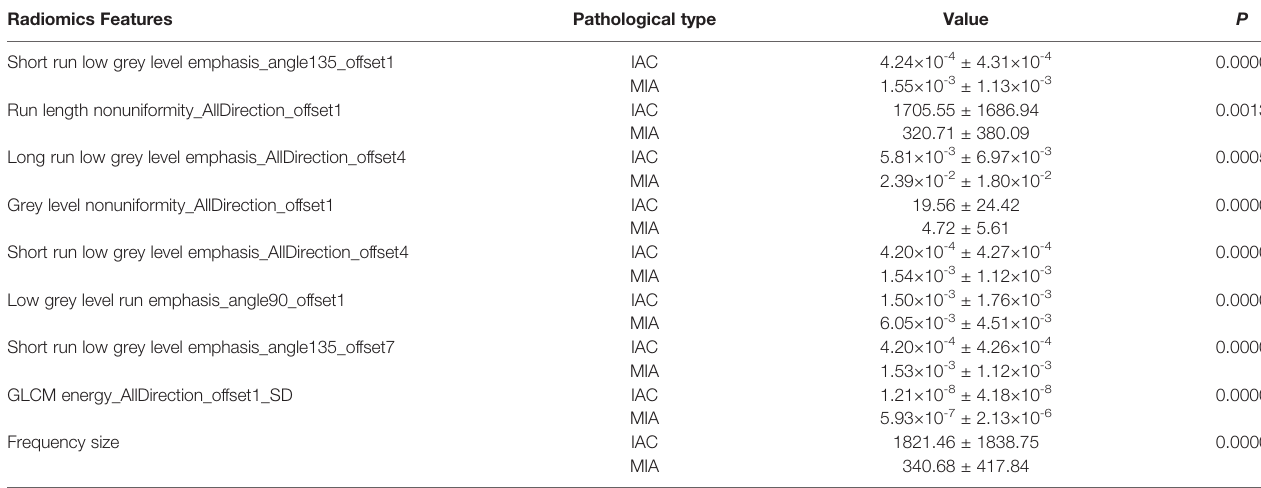
TABLE 4 | Comparative analysis of selected radiomics features between IAC and MIA. Radiomics Features